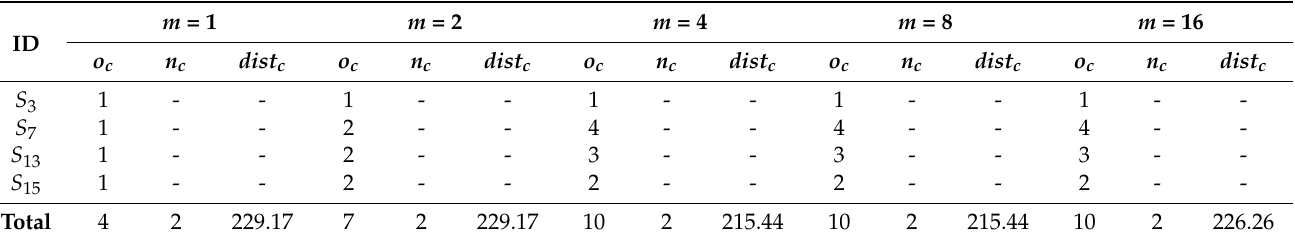
Table 4. Results of CV routing for small-sized instance c103_15.